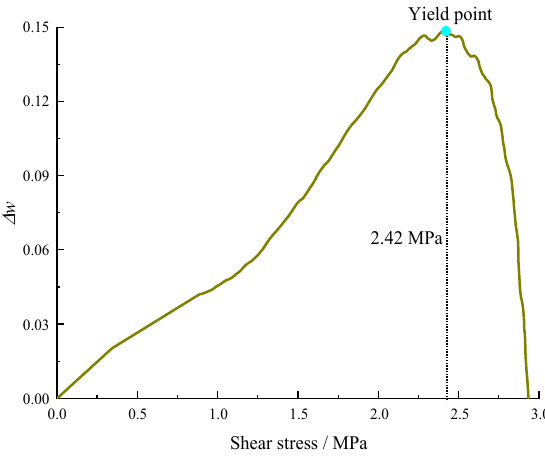
Figure 9. Determination of the yield point.